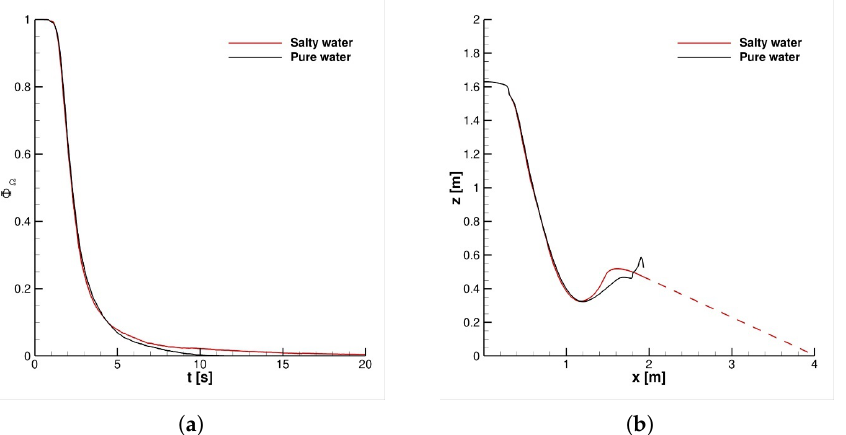
Figure 5. Effect of droplets’ chemical composition on saliva cloud reference parameters. ( a ) Fraction of particles present in the volume Ω i ; ( b ) Saliva cloud center of mass evolution.